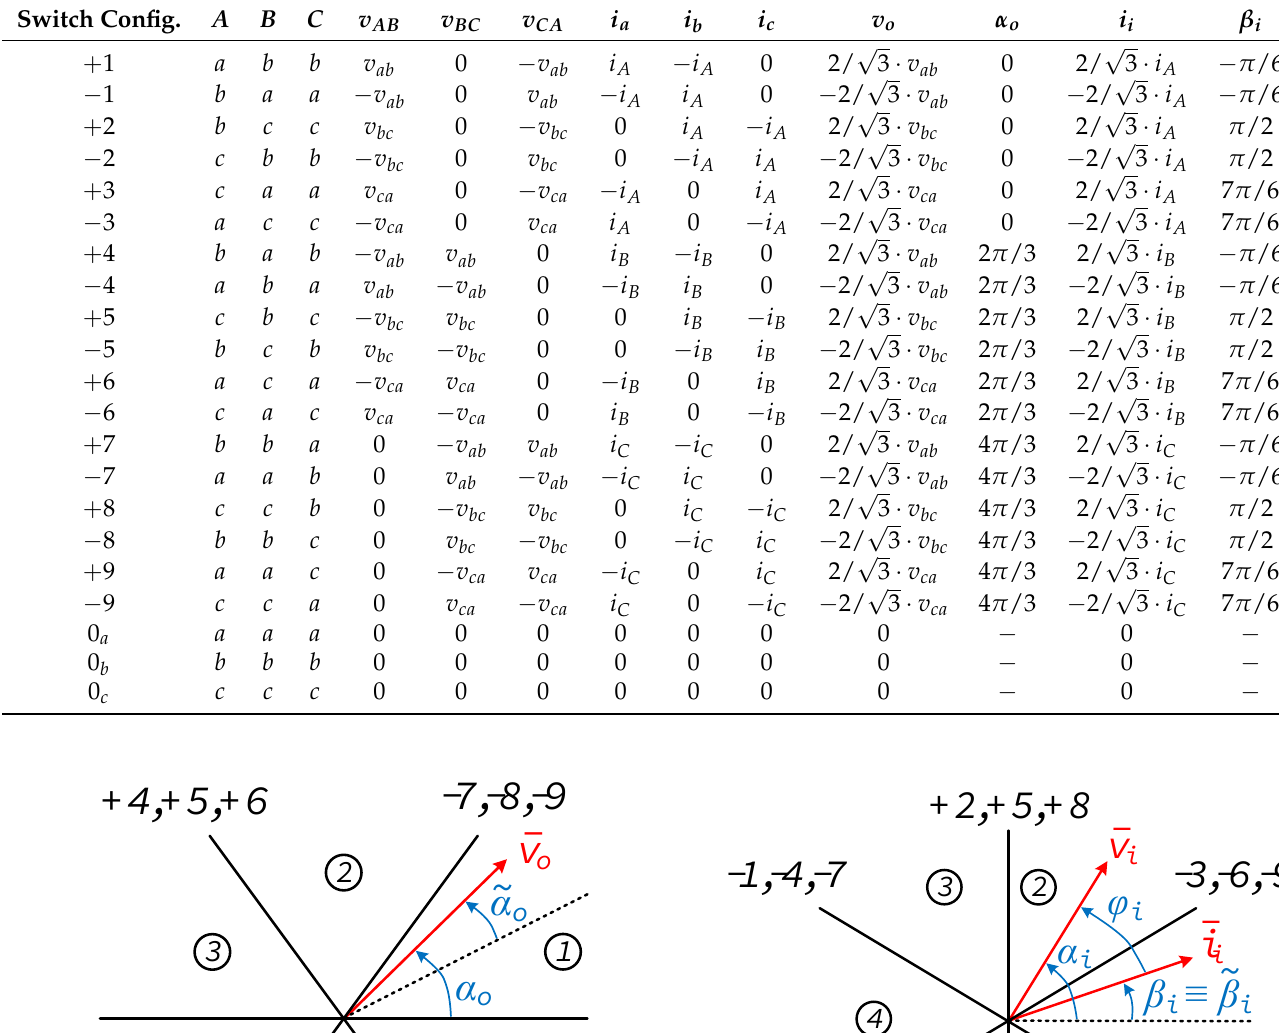
Table 1. Switching arrangements of 3 Φ -3 Φ MC employed in direct space vector modulation (SVM). Switch Config.